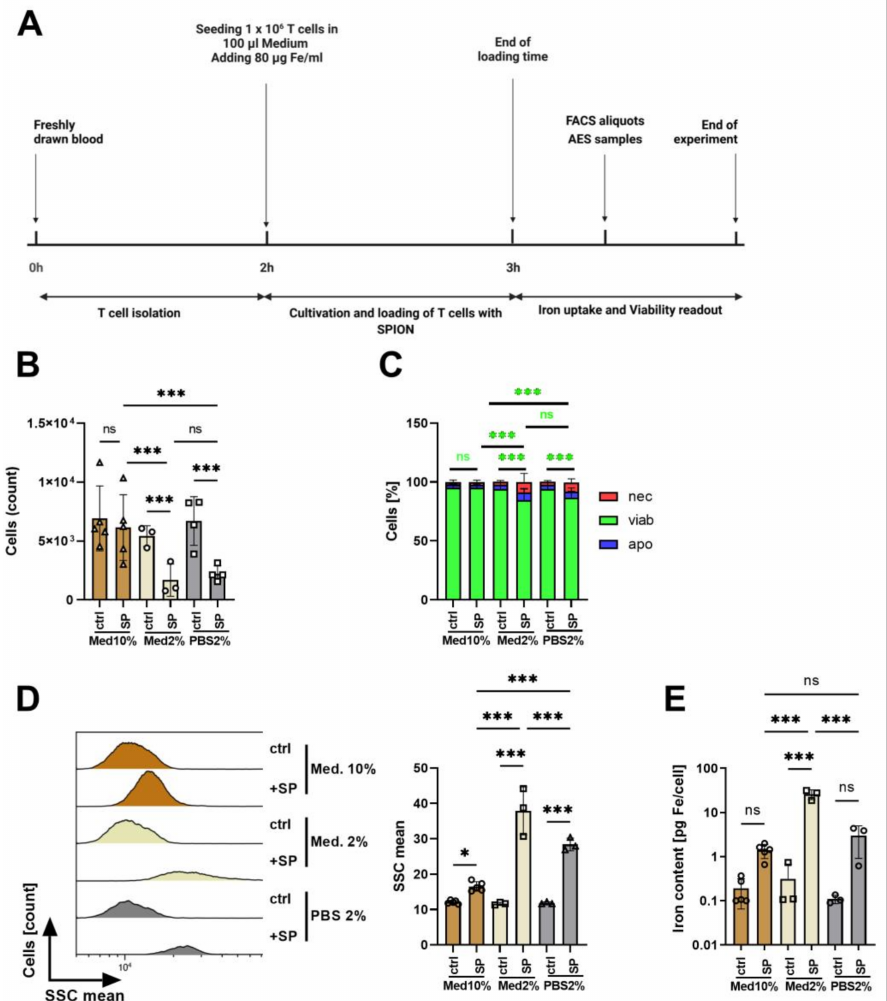
Figure 2. Influence of medium composition on SPION-loading of T cells. ( A ) Experimental setup. ( B ) Determination of the cell count by flow cytometry. ( C ) The viability of the cells was determined by AxV-FITC and PI staining in flow cytometry. AxV-FITC-/PI- cells were considered viable,